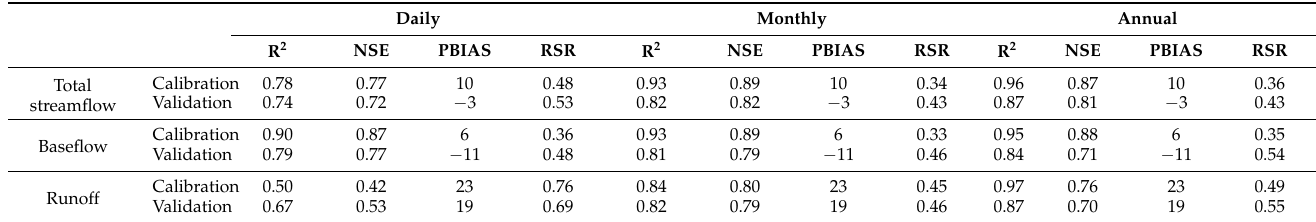
Table 2. Streamflow calibration (1990–2002) and validation (2003–2008) statistics